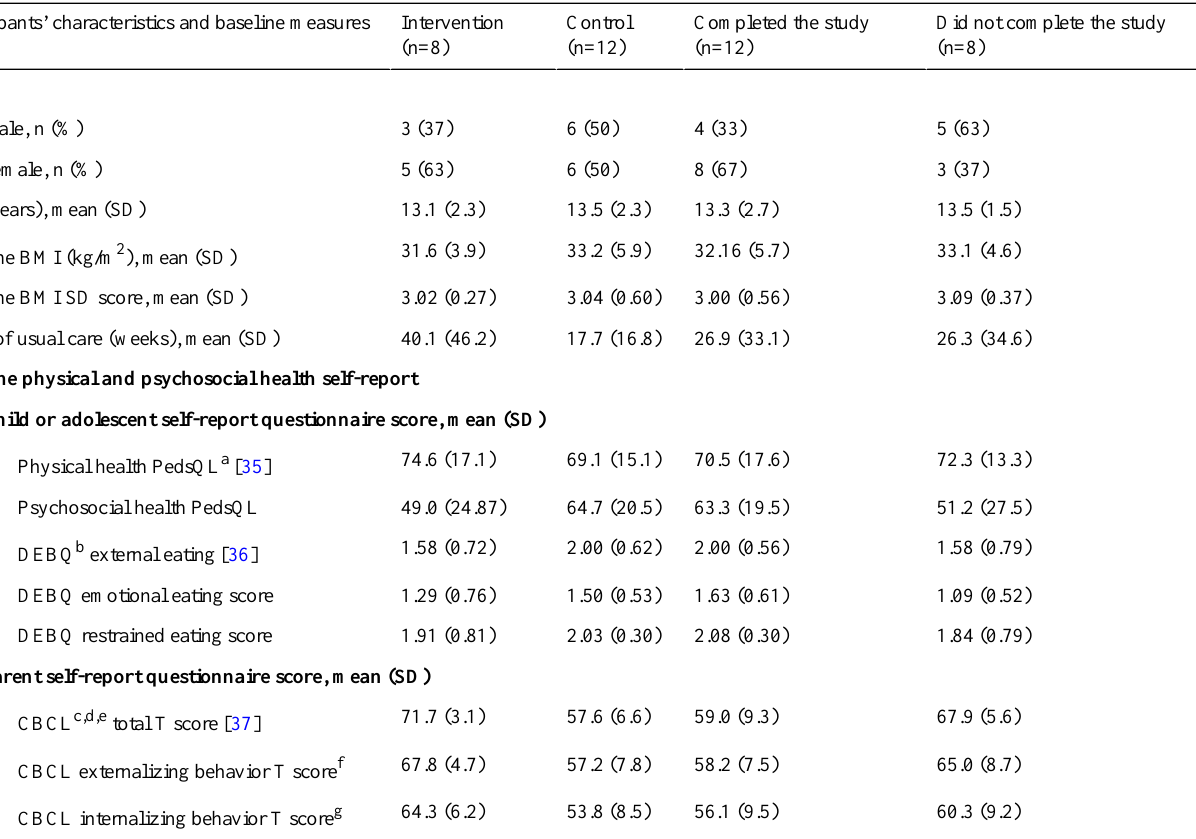
Table 1. Characteristics of participants in a randomized feasibility study for a mobile health eating behavior training intervention at baseline and